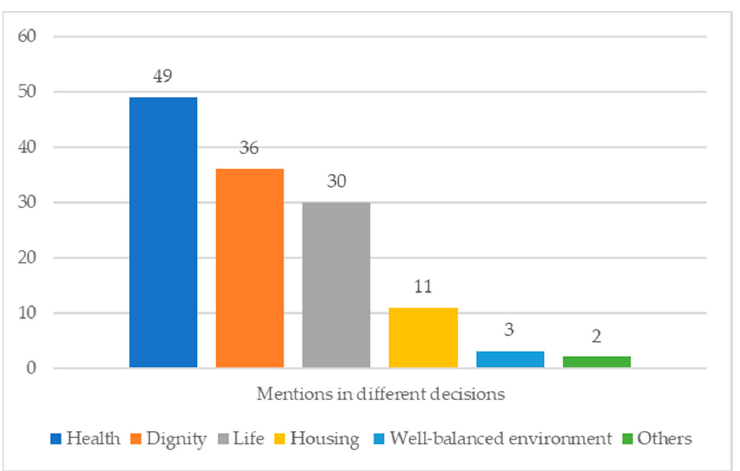
Figure 8. References to legal norms.